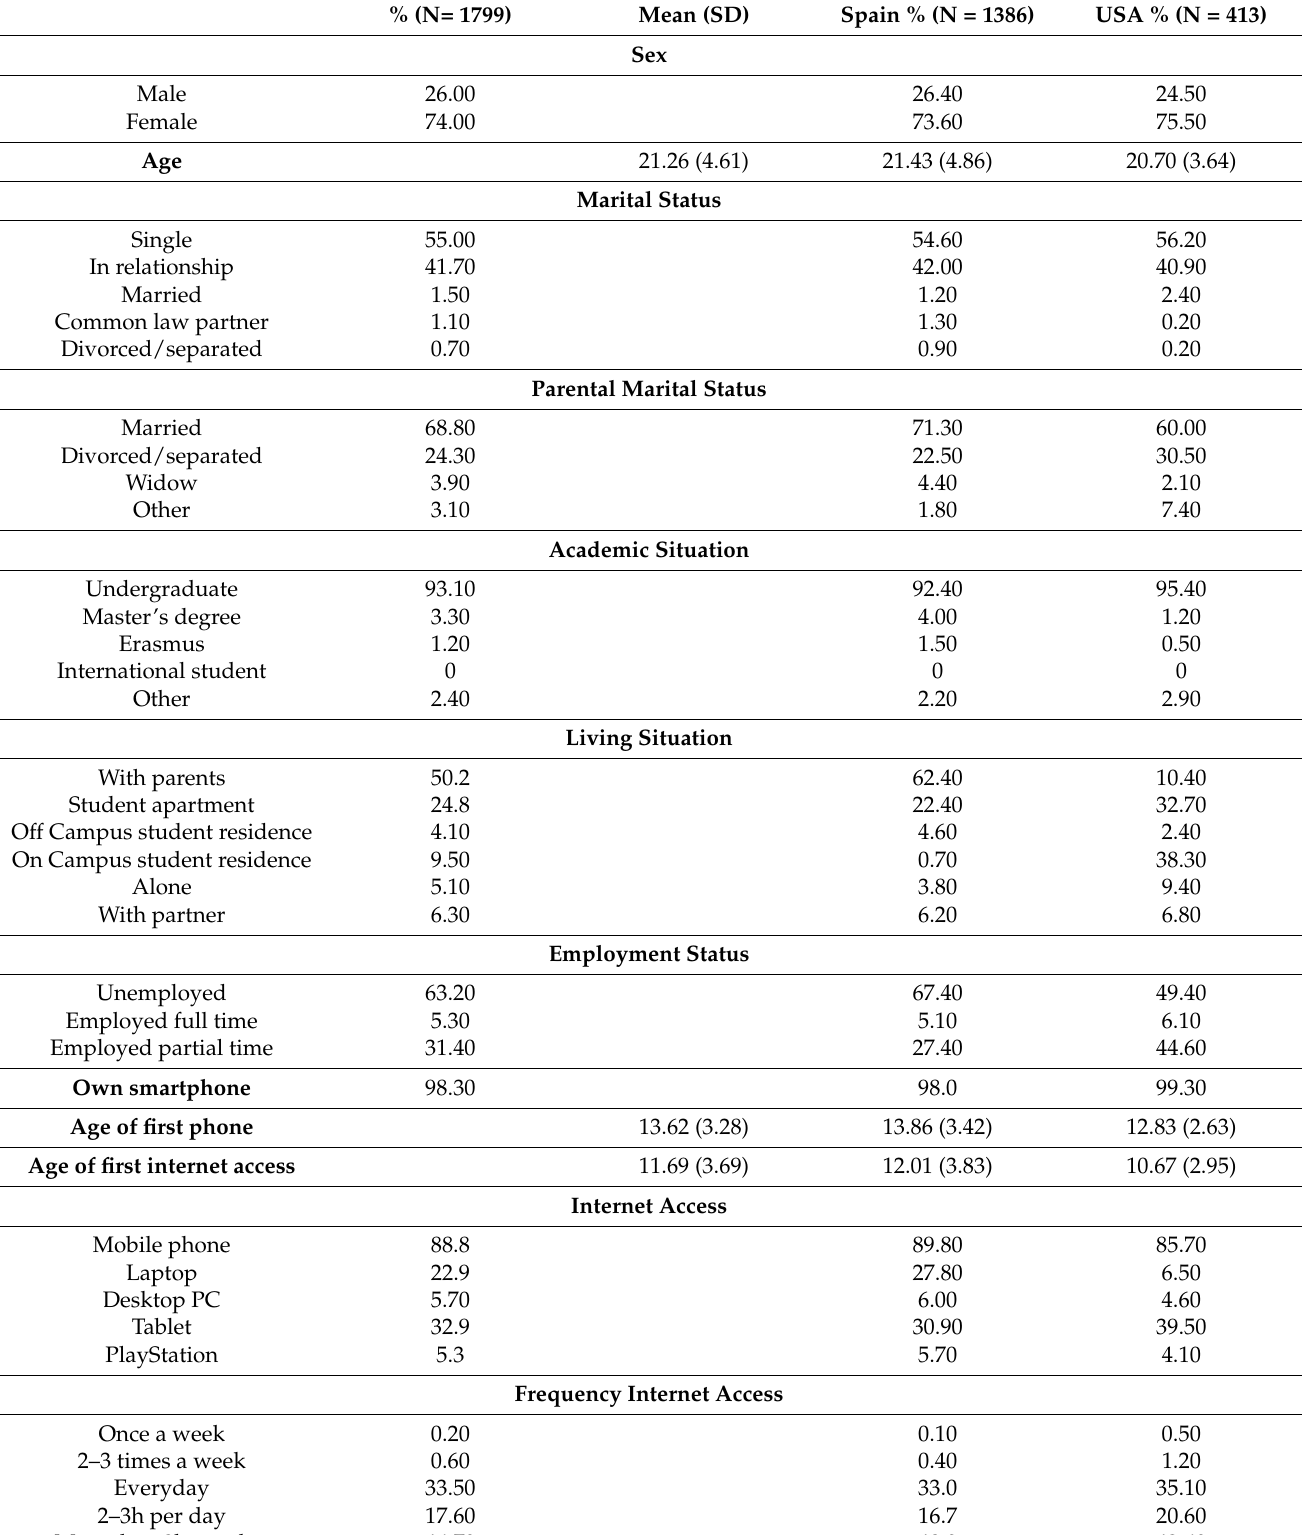
Table 1. Descriptive statistics for demographic and background